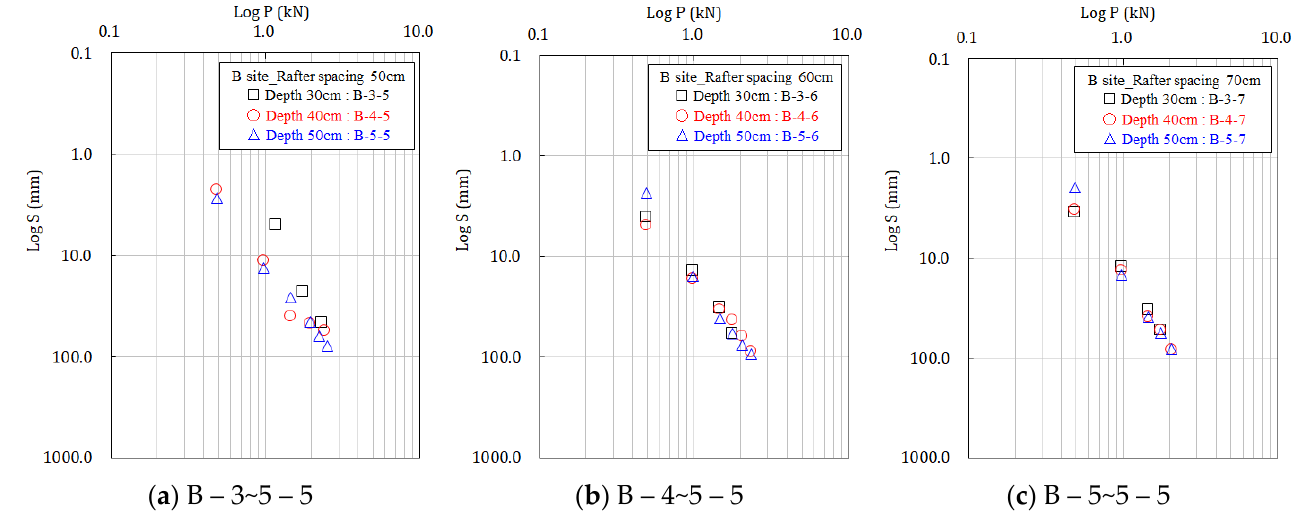
Figure 9. Results of field uplift resistance on site A.